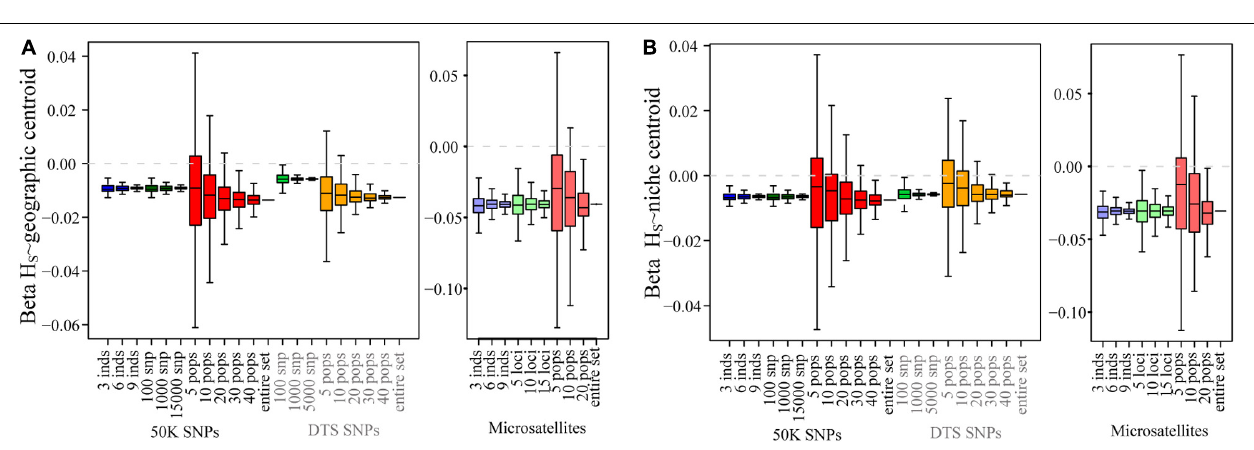
FIGURE 2 | The effect of sampling designs on the analysis of patterns of isolation for genomic and microsatellite datasets: (A) IBD-MRM test; (B) IBE-MRM test. Boxplots show the distribution of associations estimated for 1,000 simulations varying the number of individuals, number of SNPs, and number of sampled populations. The dotted gray line shows the 0 value.